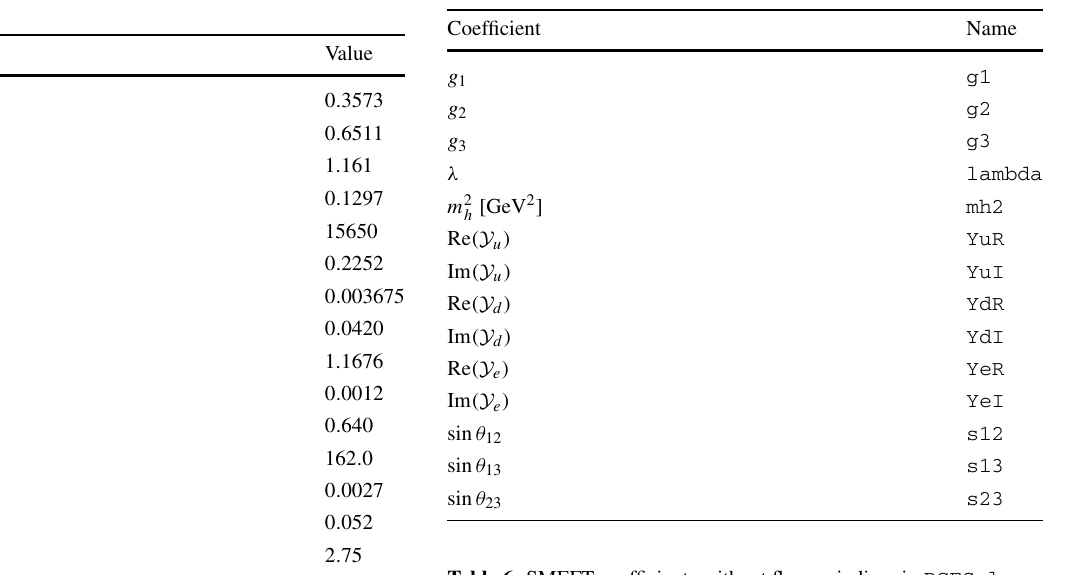
Table 6 SMEFT coefficients without flavour indices in RGESolver